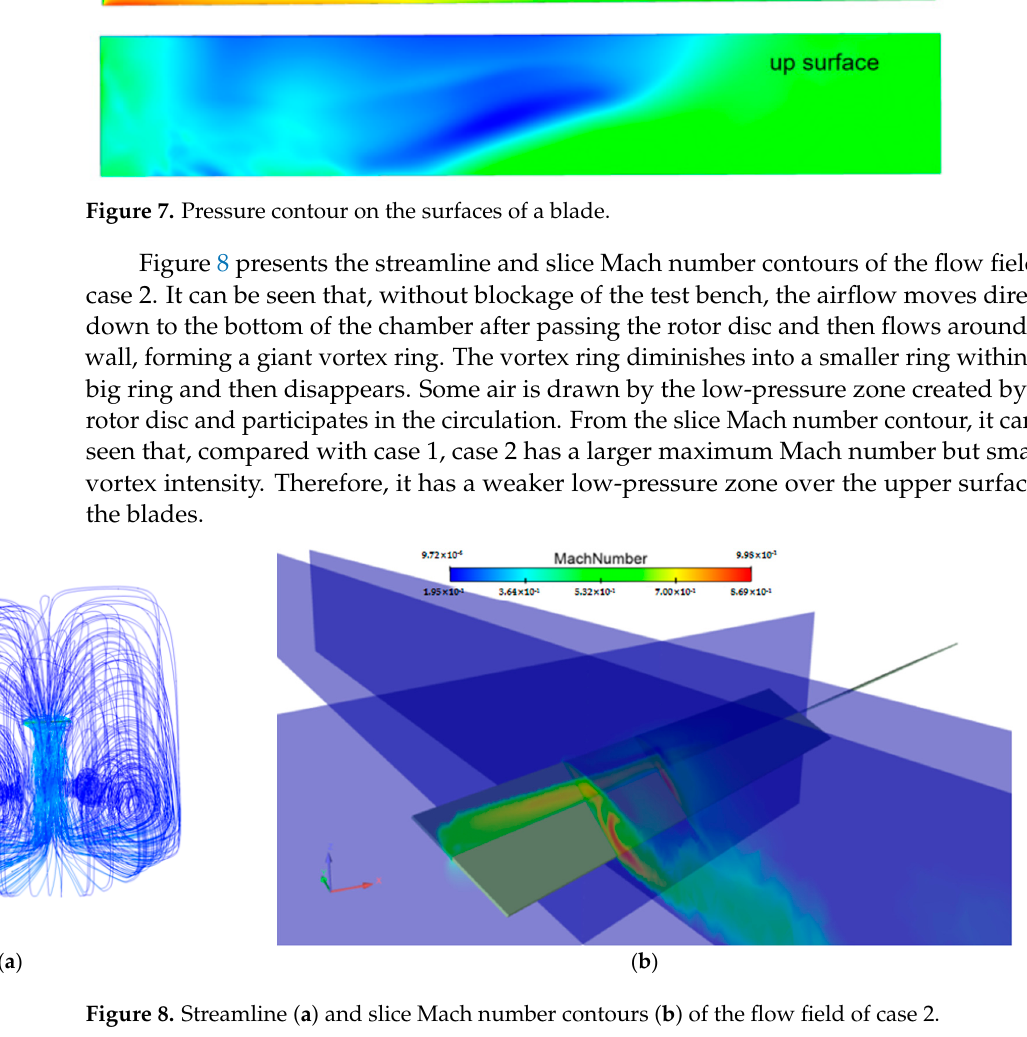
Figure 7. Pressure contour on the surfaces of a blade.